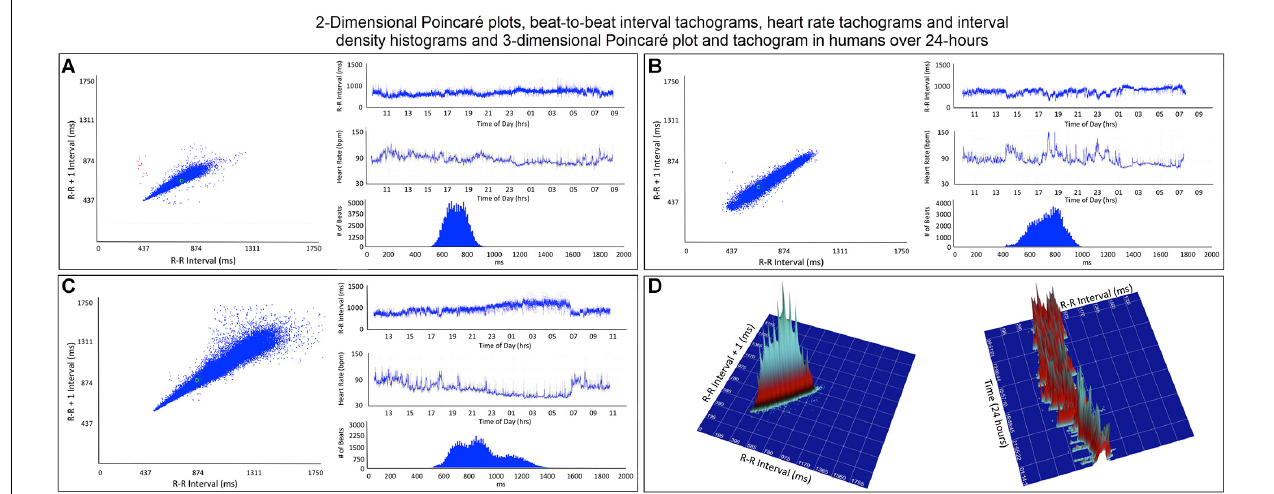
FIGURE 4 | This figure illustrates in four humans the beat-to-beat relationship shown by two-dimensional Poincaré plots and the beat distribution identified by R–R interval tachograms, heart rate tachograms and R–R interval histograms. The recording in frame (A) shows an individual with the fastest average heart rate (85 bpm) (red dots indicate low numbers of ventricular premature complexes) and the recording in frame (C) shows an individual with the slowest average heart rate (67 bpm). These three recordings (A–C) illustrate that although the density of R–R intervals (heart beat distribution) varies from fast to slow depending on physiologic needs, the heart rate in humans tends to change linearly along the line of identity. In some, the spread of intervals increases at longer intervals. Two-dimensional Poincaré plots and R–R interval tachograms do not provide an appreciation of the number of beats at a given interval. In frame (D) , three-dimensional plots of the R–R intervals from a 24-h recording from a normal human are shown as a histographic Poincaré plot (left) and tachogram (right). These type of plots provide an appreciation of the beat density for a given R–R interval on a beat-to-beat basis (histographic Poincaré plot) or over the course of time (three-dimensional interval tachogram). The amount of time examined can be selected(http://wyattflanders.com/poincare/ and